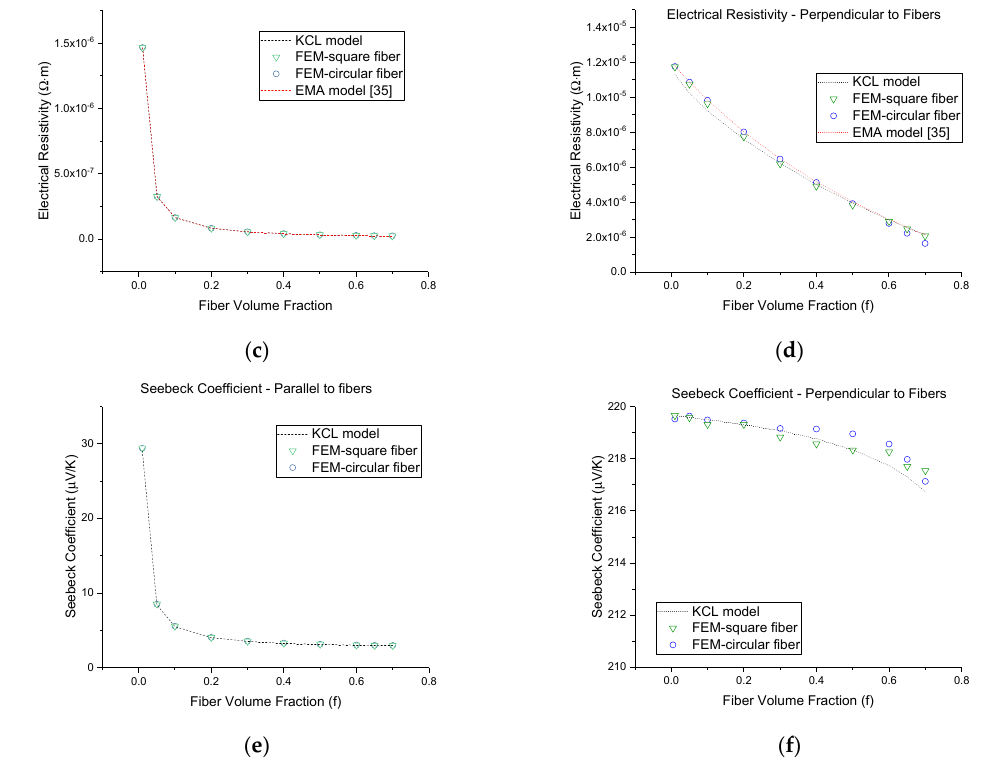
Figure 2. Thermal conductivity, electrical resistivity, and Seebeck coefficient as a function of fiber volume fraction in directions parallel and transverse to the fiber inclusions. Table 1. Material properties used in this study.